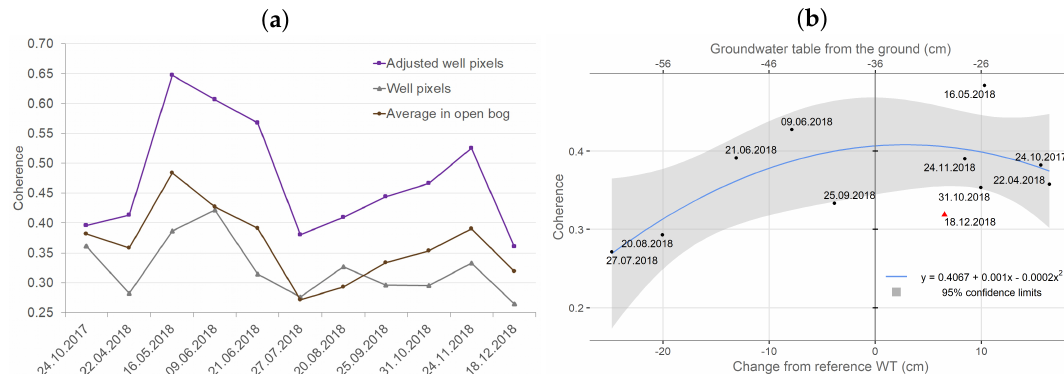
Figure 6. Mean coherence of the pixels marking the location of sampling wells compared to mean coherence of the entire open bog area ( a ) and the regression between mean coherence of the open bog and mean water table in wells ( b ). The common master image for coherence estimation is 28 May 2018. An image pair is indicated by acquisition date of the slave image. The well pixels are pixels which correspond to the exact location of the wells. The nearest-most pixels to the wells with highest average coherence are called adjusted well pixels as they are approximate locations of the wells ( a